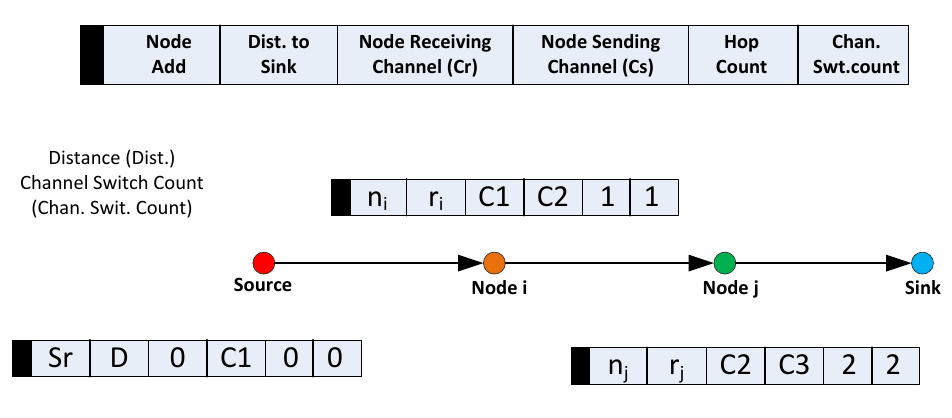
Figure 2. Route request (RREQ) operation with